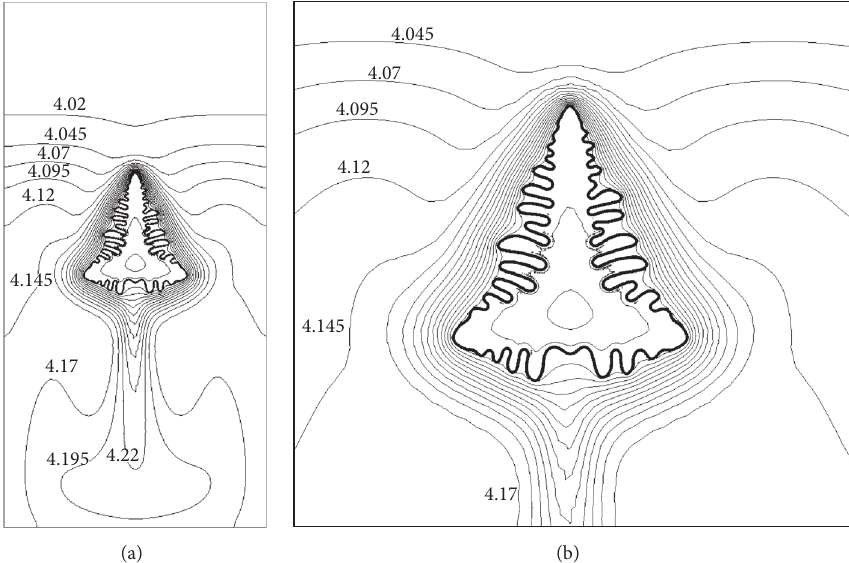
Figure 2: Isoconcentration contours around a dendrite with developed side branches. (a) The whole domain. (b) Close-up around the